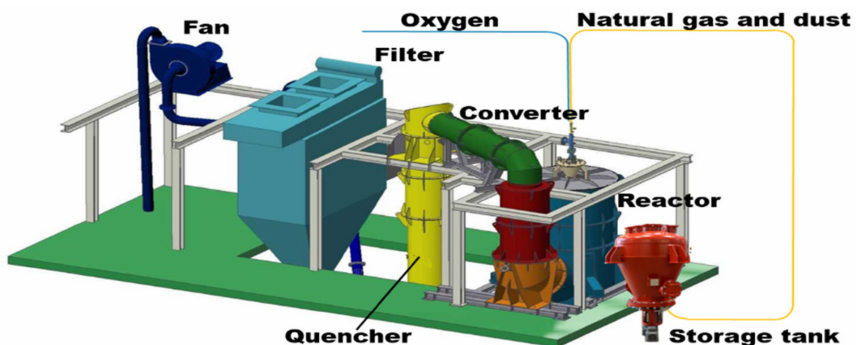
Figure 6. Schematic view of the RecoDust process